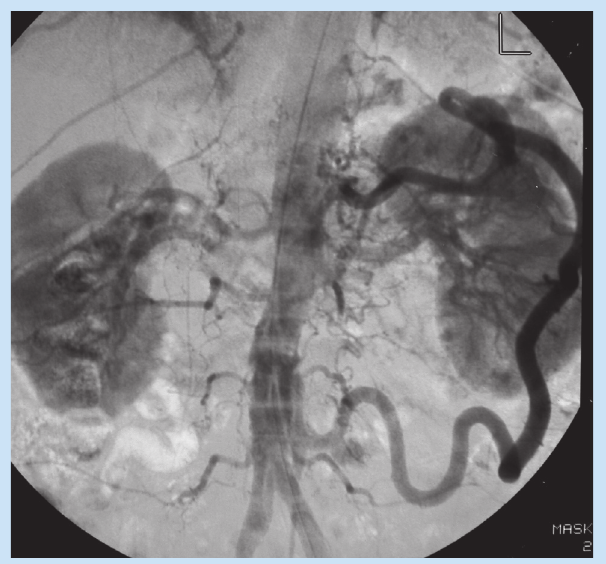
Fig. 1b. The direction of flow in the meandering mesenteric artery is shown with retrograde filling of the middle colic branch of the superior mesenteric artery. There is subsequent filling of the superior mesenteric artery by the middle colic